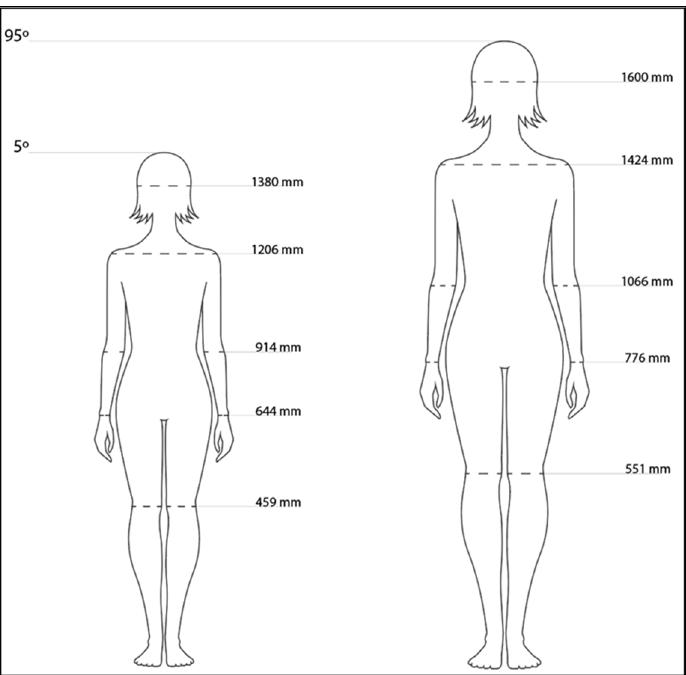
Figure 7. Anthropometric data for the P5º and P95º of the female Portuguese population [29] (expressed in mm, with footwear correction included).